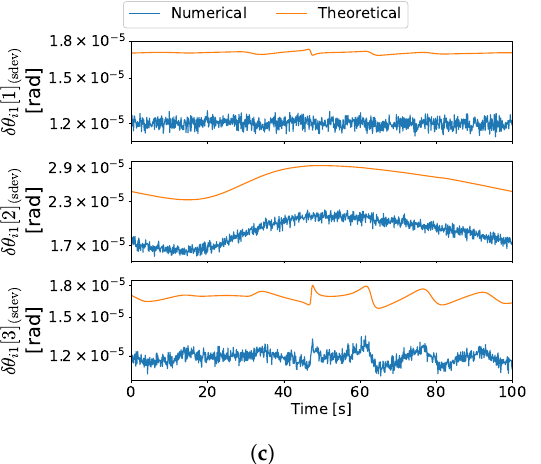
error standard deviation in 2 error standard deviation in 1